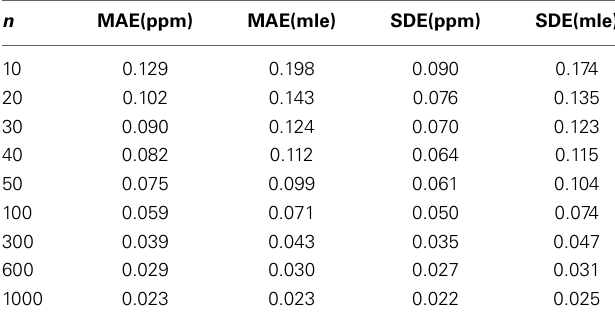
Table 2 | The mean absolute value error (MAE) for the θ d parameter for both the PPM and MLE